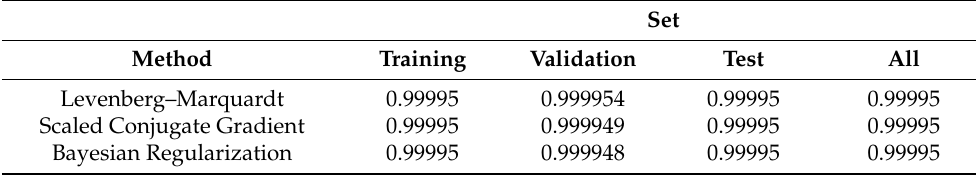
Table 6. Circles error measures ( r )— y position.